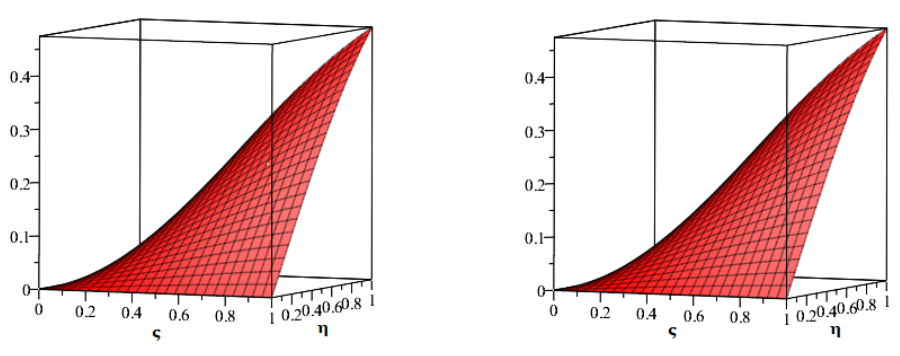
Figure 1. The proposed method solution and accurate solution at γ = 2.